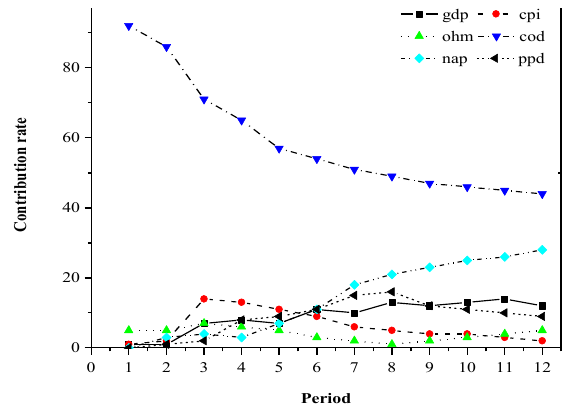
Figure 3. The decomposition of variance for GDP.